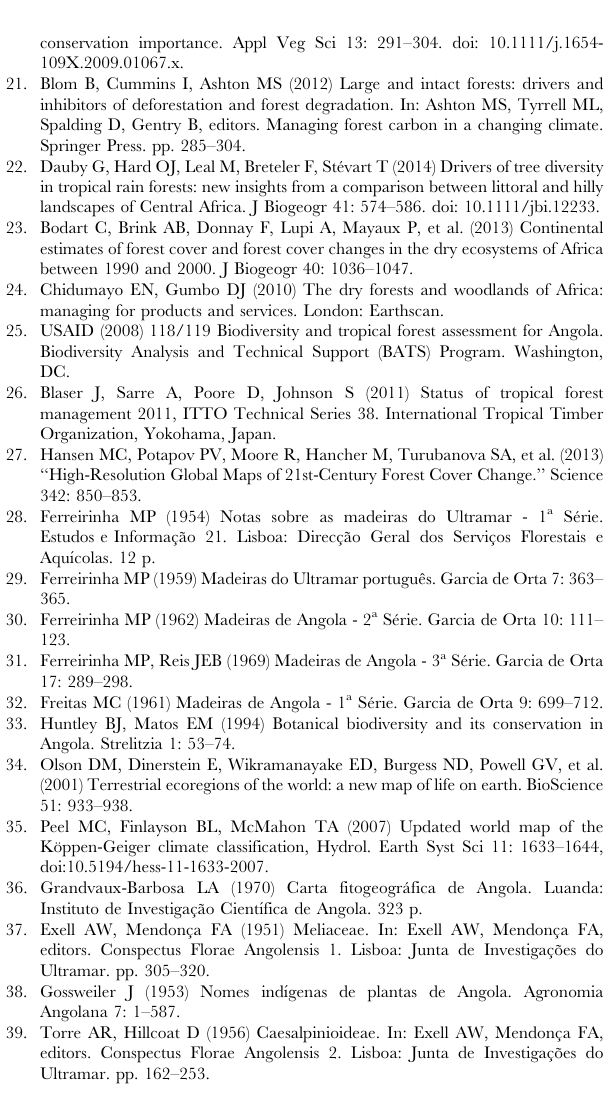
Table S2 Sixty-two datasets from GBIF providers queried for the 18 timber species, producing 2253